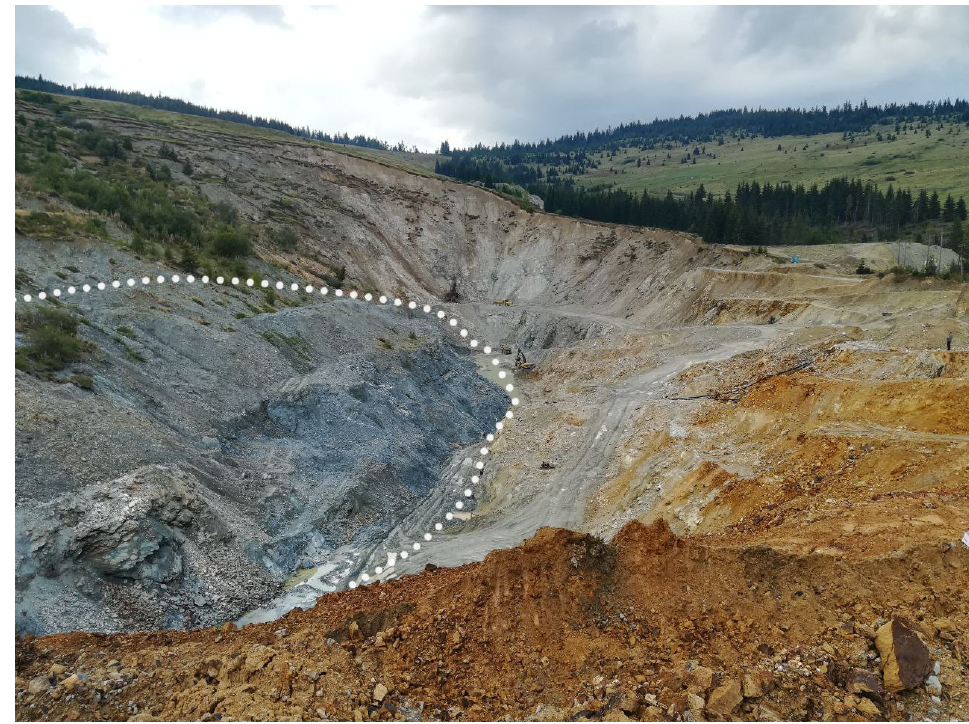
Figure 3. Panoramic view of the Mănăilă open pit (photo date: September 2018). The dotted line represents the mineralization presented in rhyolitic metatuffs.